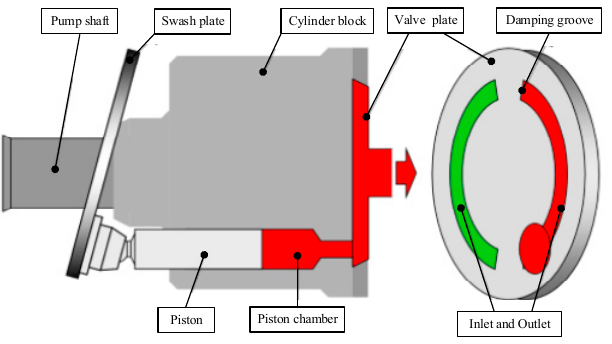
Figure 2. The port plate pair of axial piston pump.